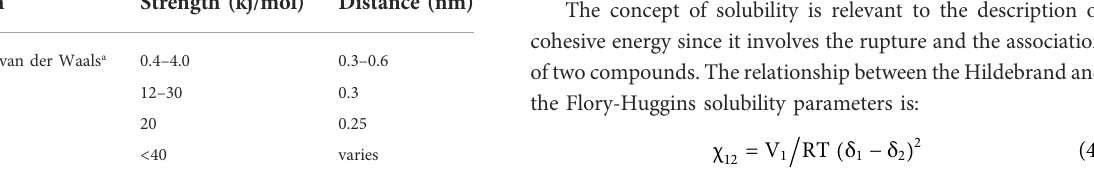
TABLE 2 Percentage of the Debye (permanent-permanent), Keeson (permanent-induced) and London (induced-induced) contributions to van der Waals dipolar interactions, as related to the permanent dipole and polarizability of typical compounds. Compound